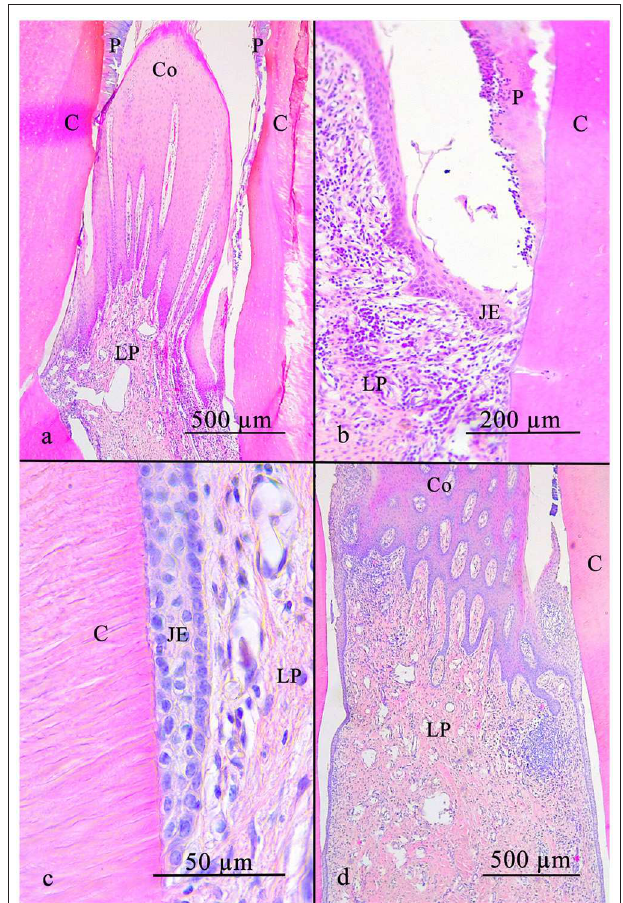
FIGURE 5 | Lamina propria of the gingiva. (a) Note the diffusely spread blood vessels. (b) Local accumulation of leucocytic infiltrates near the sulcular epithelium (SE). C, cementum; SE, sulcular epithelium; LP, lamina propria. FIGURE 6 | The equine interdental gingiva is cone shaped and has a